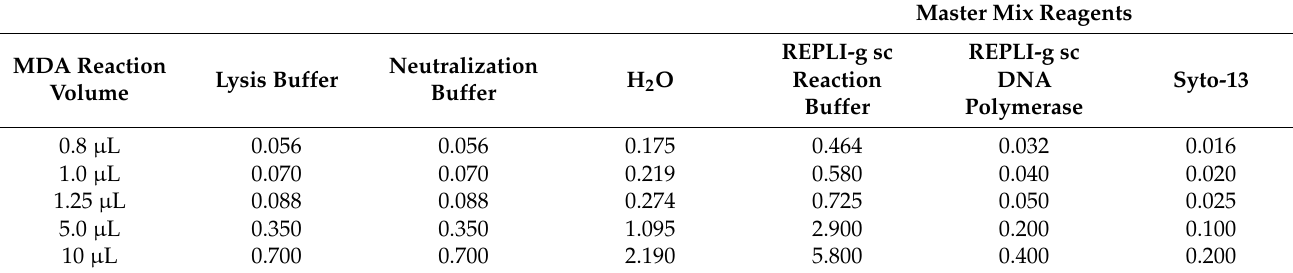
Figure A2. Genome coverage by sequencing effort of MDA in 1.25 µ L reaction volumes. Trimmed reads were down-sampled from all 1.25 µ L samples ( n = 5) to 200 × , 100 × , 80 × , 60 × , 40 × , 20 × using BBmap reformat.sh [76]. Down-sampled reads were then mapped to E. coli MG1655 reference genome with bbmap.sh. Standard error bars were calculated using all five replicates. Table A1. MDA reagents by reaction volume.